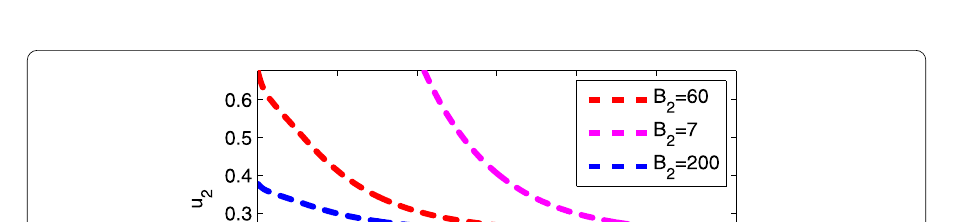
Figure 15 Plot of different weight constants on the control u 1 .